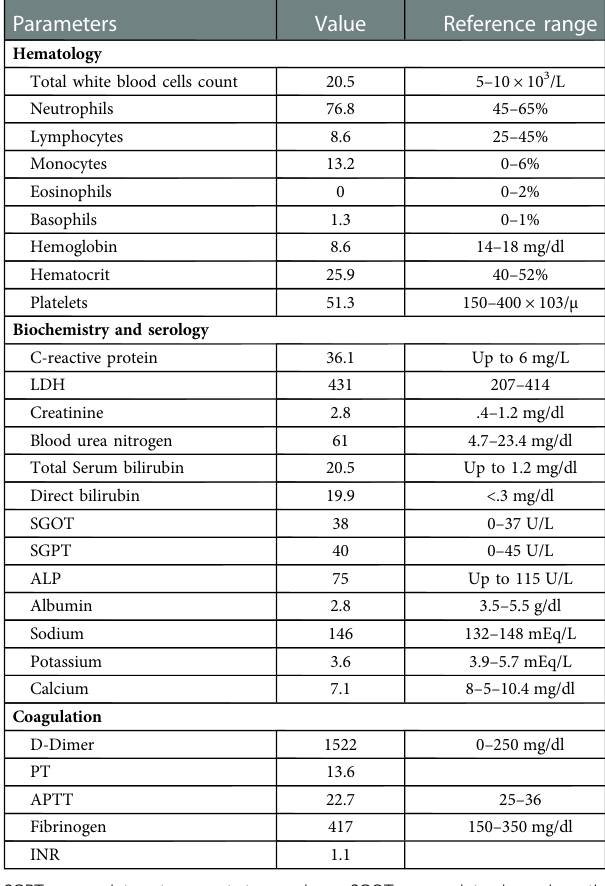
TABLE 1 Laboratory data on